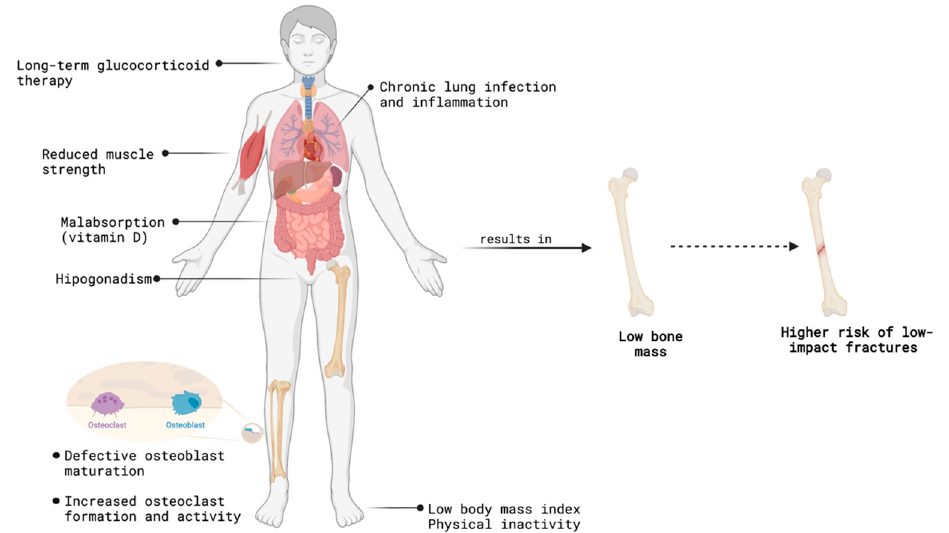
Figure 2. Cystic fibrosis bone disease is a multifactorial disease due to chronic organ involvement, the direct impact of CFTR dysfunction and long-term therapeutical approaches. Scheme was created using Biorender.com (www.biorender.com; access on 22 November 2022).